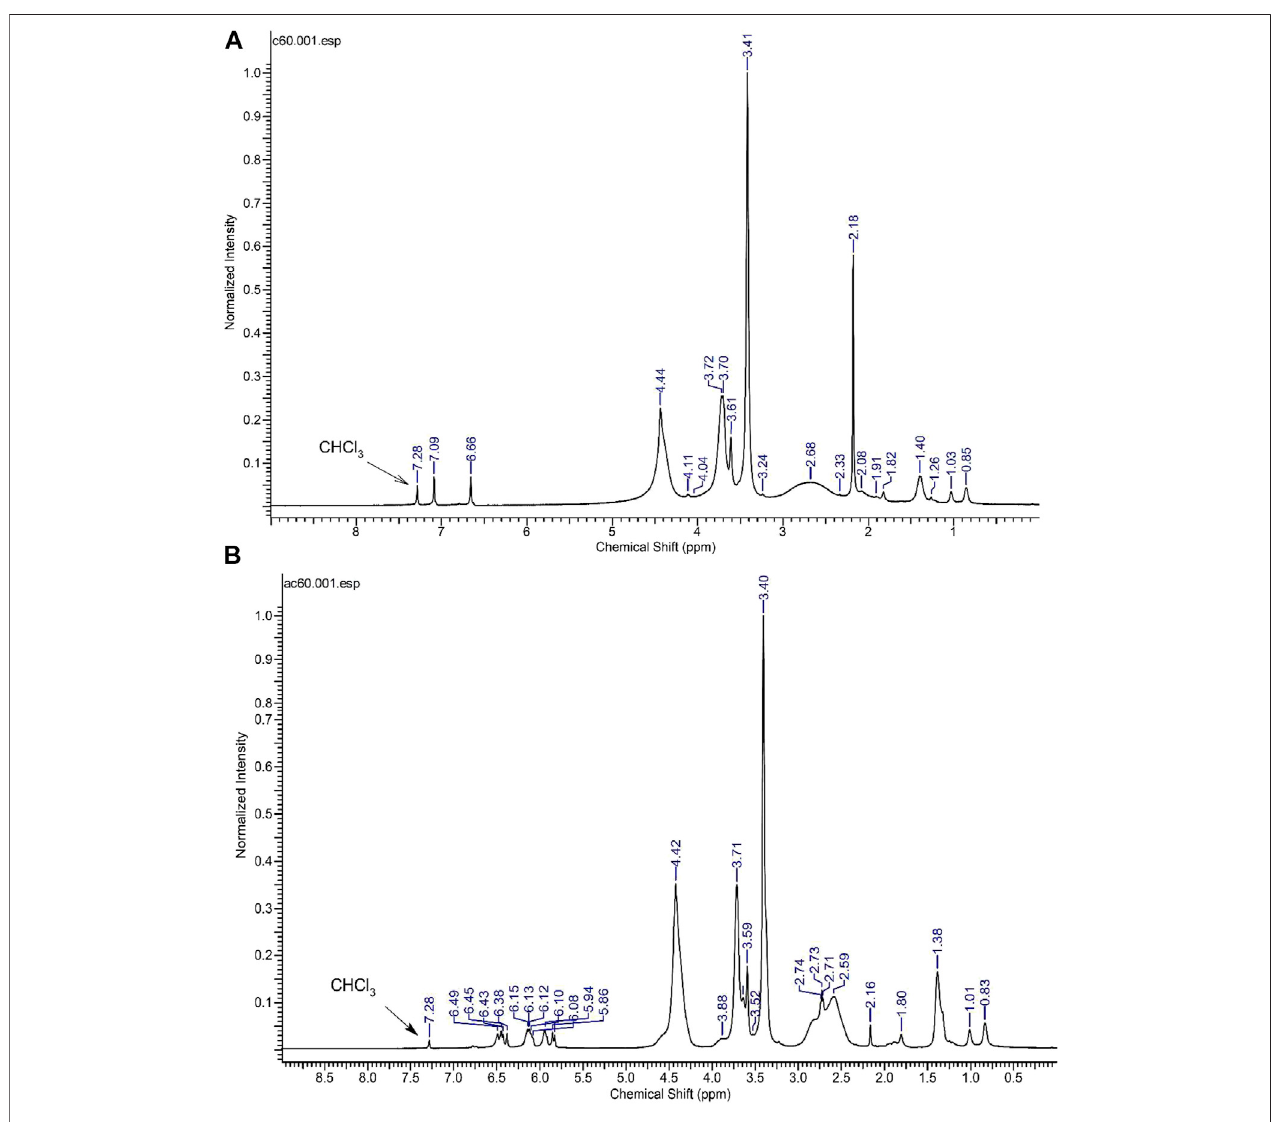
FIGURE 7 | 1 H NMR spectrum of the polymerized CA dissolved in CDCl 3 (A) and polymerized CA/AA dissolved in CDCl 3 (B) .